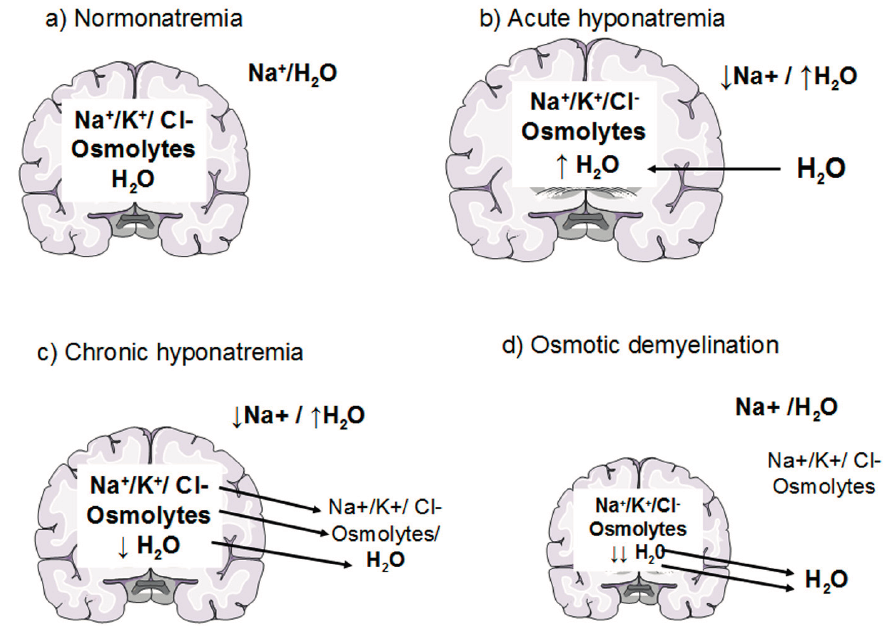
Figure 1. Effects of hyponatremia on the brain and adaptive mechanism. ( a